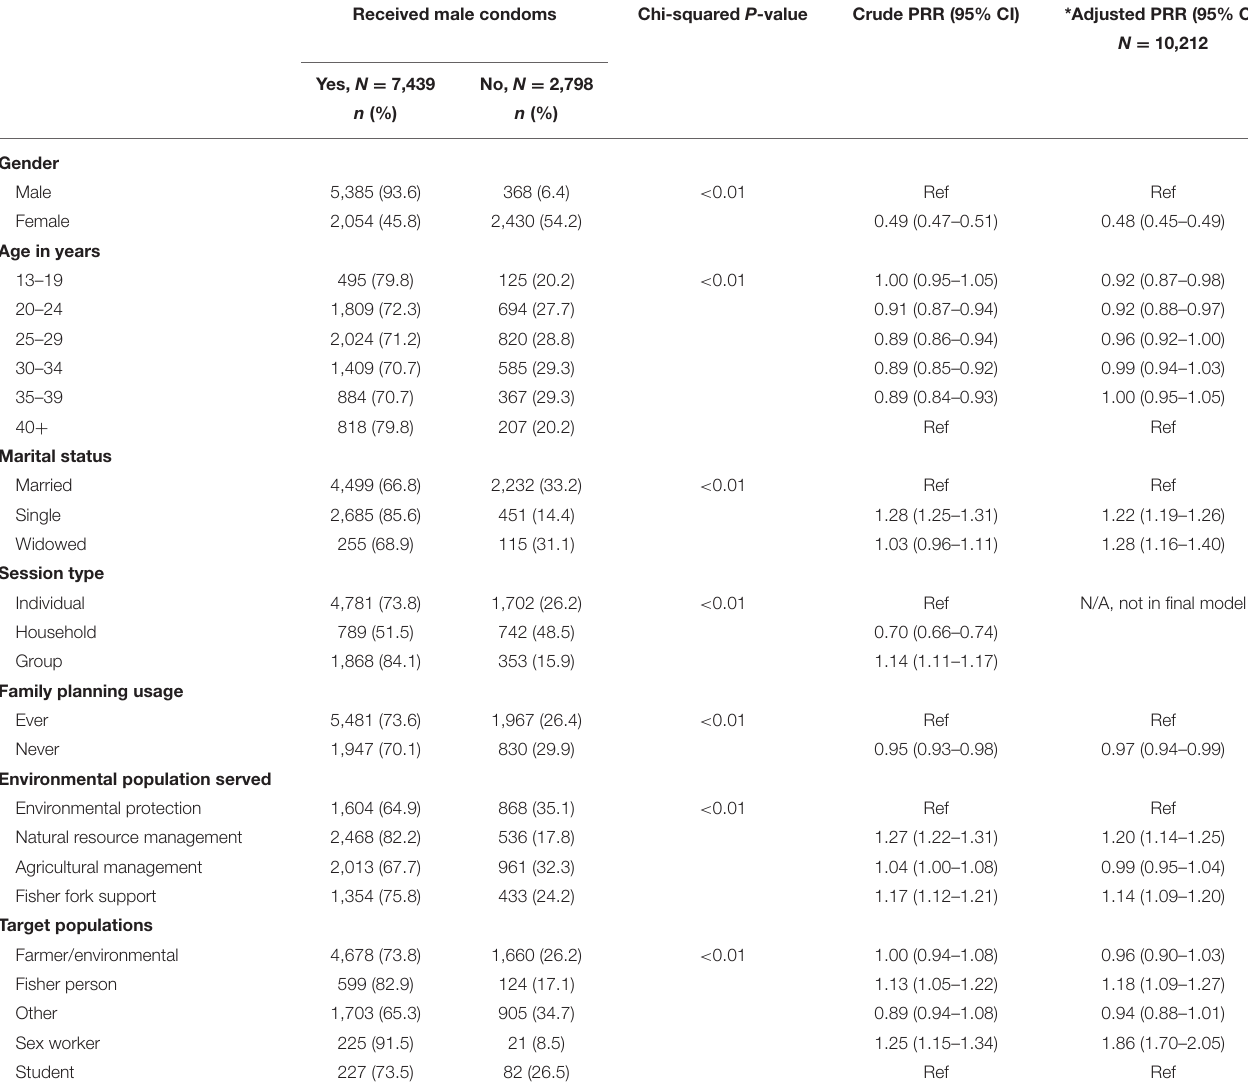
TABLE 4 | Results of multivariable log-binomial regression: factors associated with receiving any male